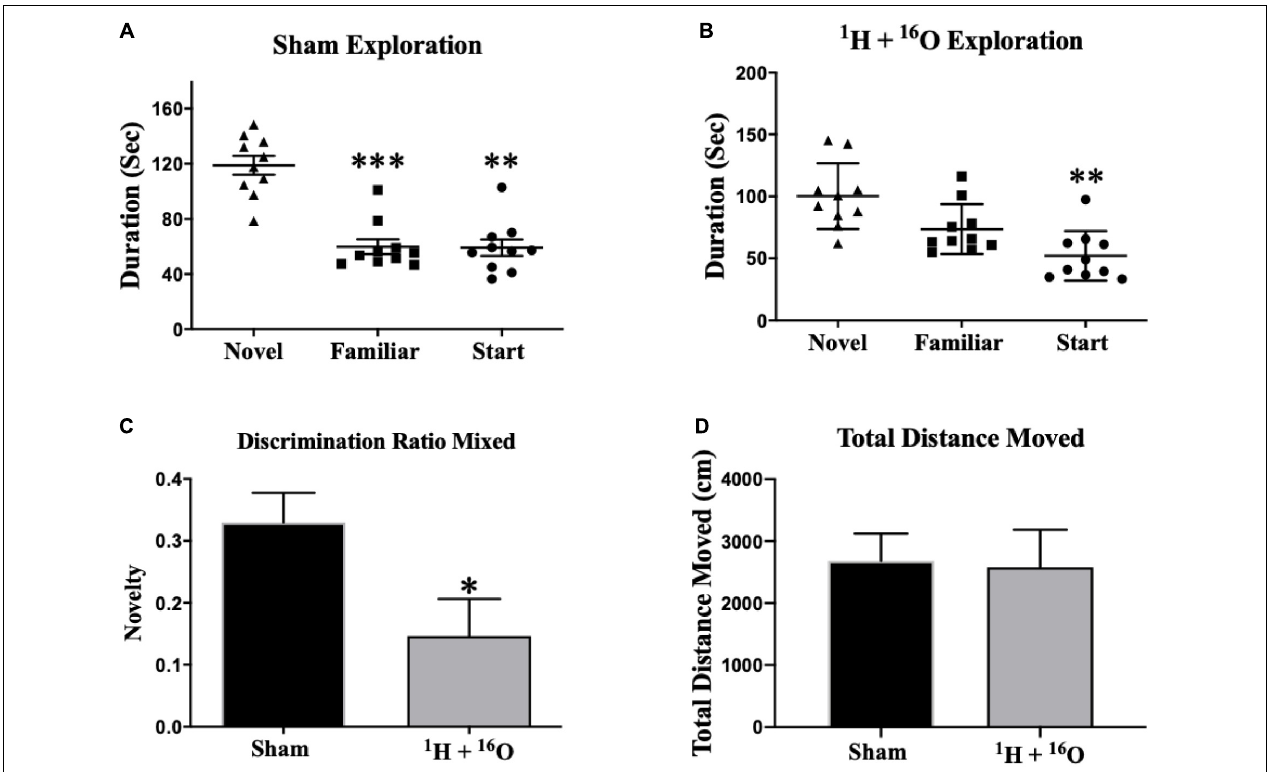
FIGURE 1 | Y-maze. (A) Sham-irradiated mice explored the novel arm for a significantly longer duration than the other arms during testing, indicating normal short-term spatial memory. (B) Irradiated animals spent more time exploring the novel than the start arm, but they were unsuccessful in exploring the novel arm for a longer duration than the familiar arm, implying spatial memory injury. (C) Discrimination ratios for both treatment groups reveal a marked decrease in novel arm discrimination for irradiated animals. (D) There was no effect of radiation on gross locomotor activity based on mean total distances moved. Average ± SEM ( n = 10); * P < 0.05, ** P < 0.01, *** P <